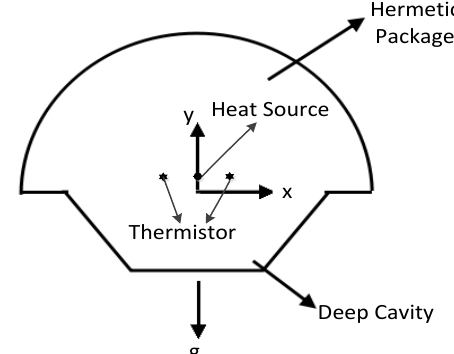
Figure 2. 2D structure of the airflow inclinometer’s sensing